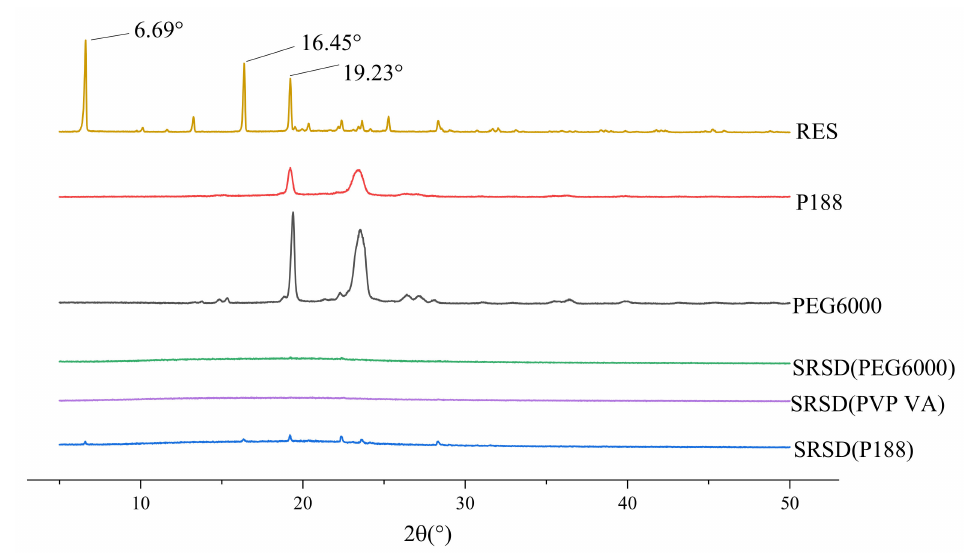
Figure 4. XRD diagram of solid dispersion prepared by different release modifiers.